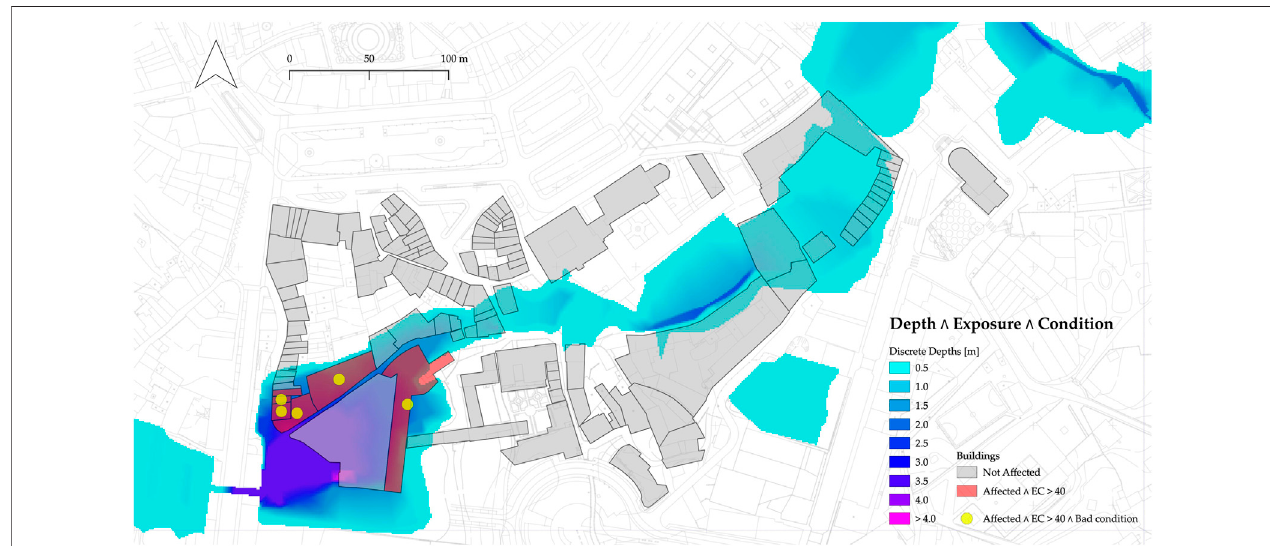
FIGURE10| Exampleofajointanalysisofwaterdepth,exposure,andcondition(i.e.,buildings ’ conservationstate)indicators(FerreiraandSantos,2020).Thiskind of output makes it easy to analyse fl ood risk scenarios from the combination of hazard and physical vulnerability-related results.